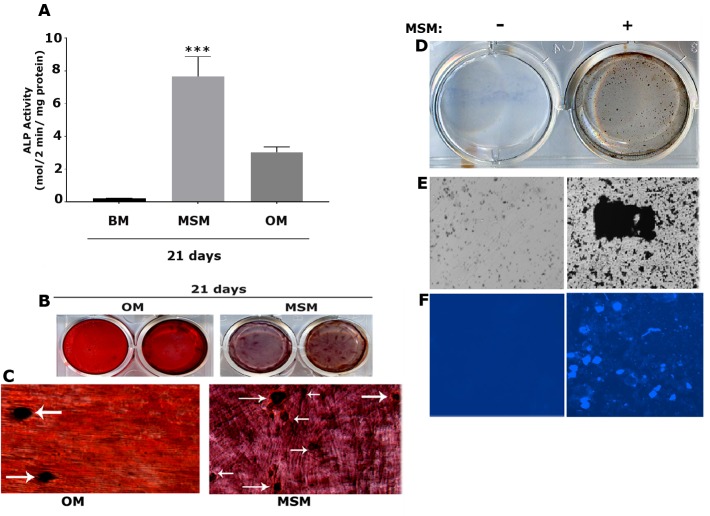
Detection of mineralized matrix and calcium deposits in response to MSM treatment for 21 days.A. ALP activity was determined in SHED cells treated with MSM for 21 days. SHED cells treated with osteogenic medium (OM) and basal medium for 21 days were used as controls. Data are expressed as the mean with error bars representing SD (n = 3). ****p<0.0001 vs. OM-treated cells for 21 days. B and C: Mineralization was assessed by Alizarin red staining (ARS) in SHED cells treated with MSM for 21 days. Cells treated with osteogenic medium (OM) and MSM are shown in duplicate (B). Representative magnified phase-contrast micrographs (40X magnification) are shown in C. Arrows indicate mineralized nodules in OM and MSM panels (C). Data shown are representative of three independent experiments. D-F: Analysis of mineralized nodule formation by Von Kossa (VK; panels D and E) and calcein blue (CB; panel F) staining in vitro. An enlarged view of a VK stained nodule is shown in E (+). Fluorescence analysis of the calcein bound mineral nodules containing calcium are shown in F (+). Magnification is 100X in E and F. Cells in BM (-) was used as a control. Data shown are representative of three independent experiments.